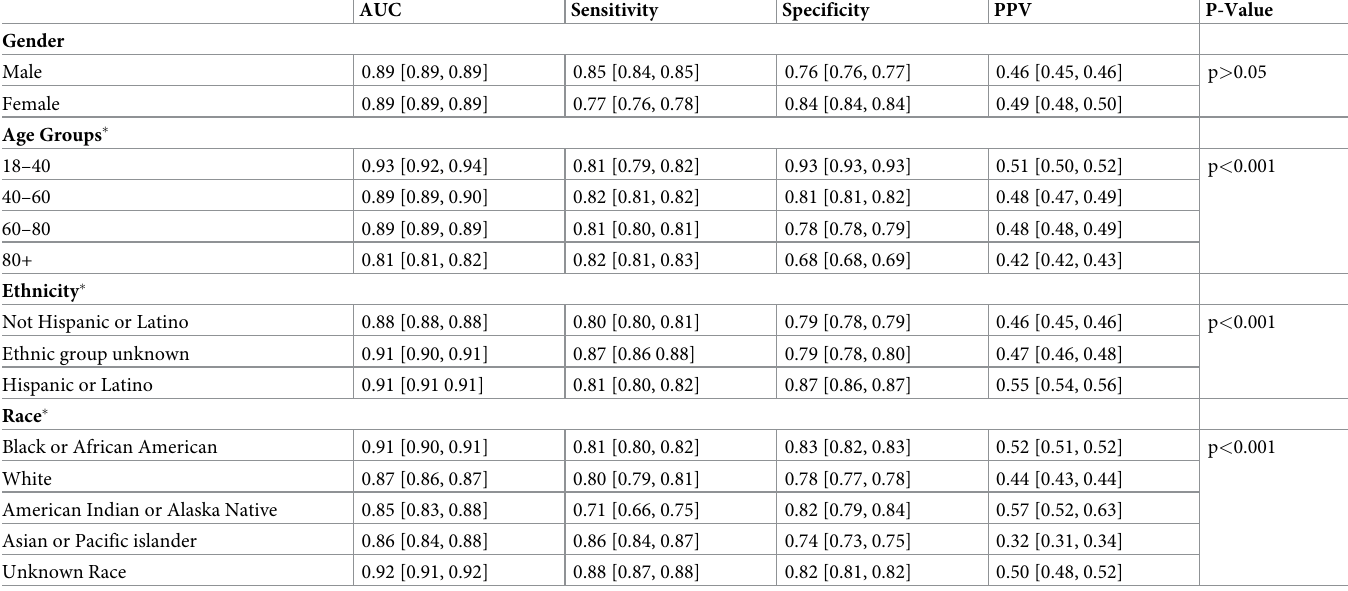
Table 4. Analysis of model performance on the hold-out CRD dataset across demographics.